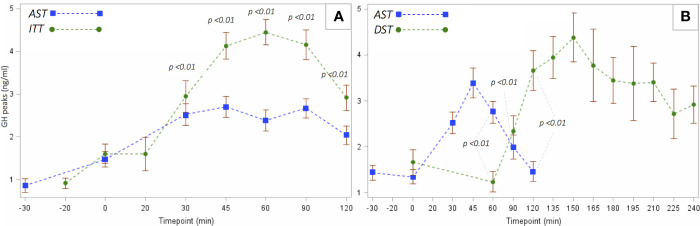
Comparison of the mean GH values recorded at each timepoint between AST and ITT
(A) and between AST and DST
(B). Bonferroni-corrected α: 0.01 for GHITT and 0.017 for GHDST.